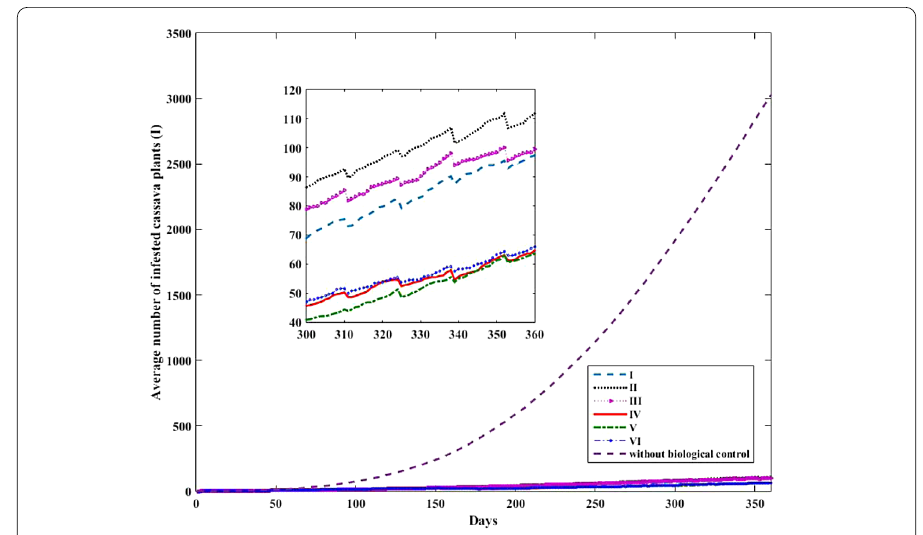
Figure 4 The average number of infested cassava plants